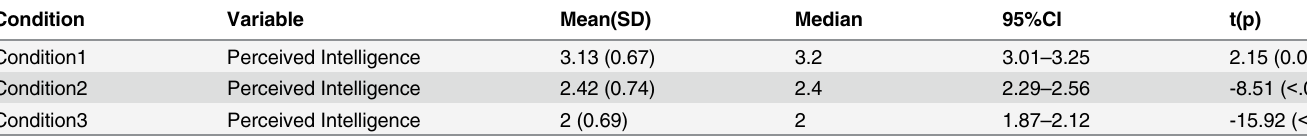
Table 5. Descriptive statistics for Perceived Intelligence.